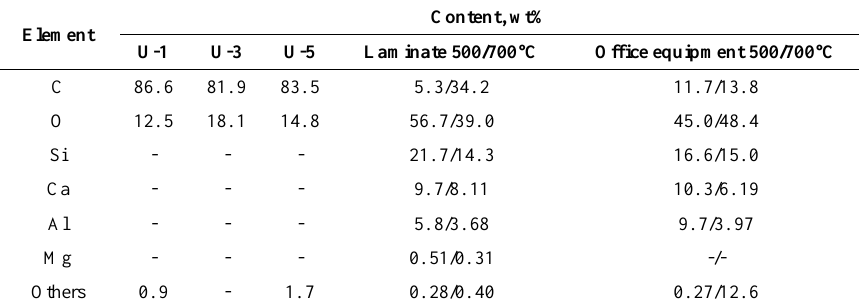
Table 3. X-ray fluorescence analysis of thermally recovered fibers